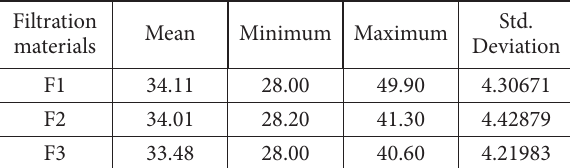
Table 7. Average temperature values measured by filtration